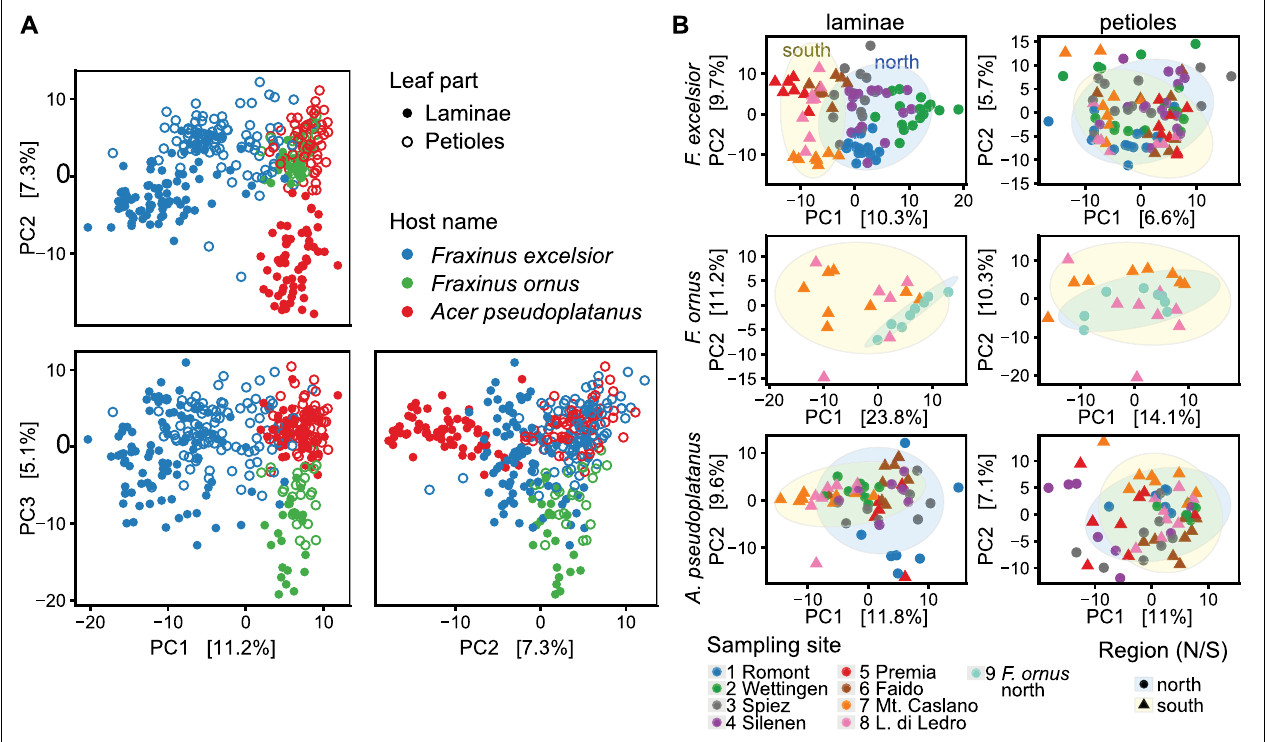
FIGURE 6 | Unconstrained ordination using principle component analysis (PCA) of CLR-transformed OTU counts. The percentages explained by each axis are shown in square brackets. H. fraxineus was excluded from this analysis. (A) Ordination including all samples, colored according to the host species. Filled circles indicate lamina (L) and open circles petiole samples (P). Combinations of the first three axes (PC1-3) are shown. (B) Ordination done separately for each host species and leaf part (PC1 and 2 shown). Tree communities north of the Alps are outlined with a blue elliptic background and samples from the south have a yellow background (confidence level: